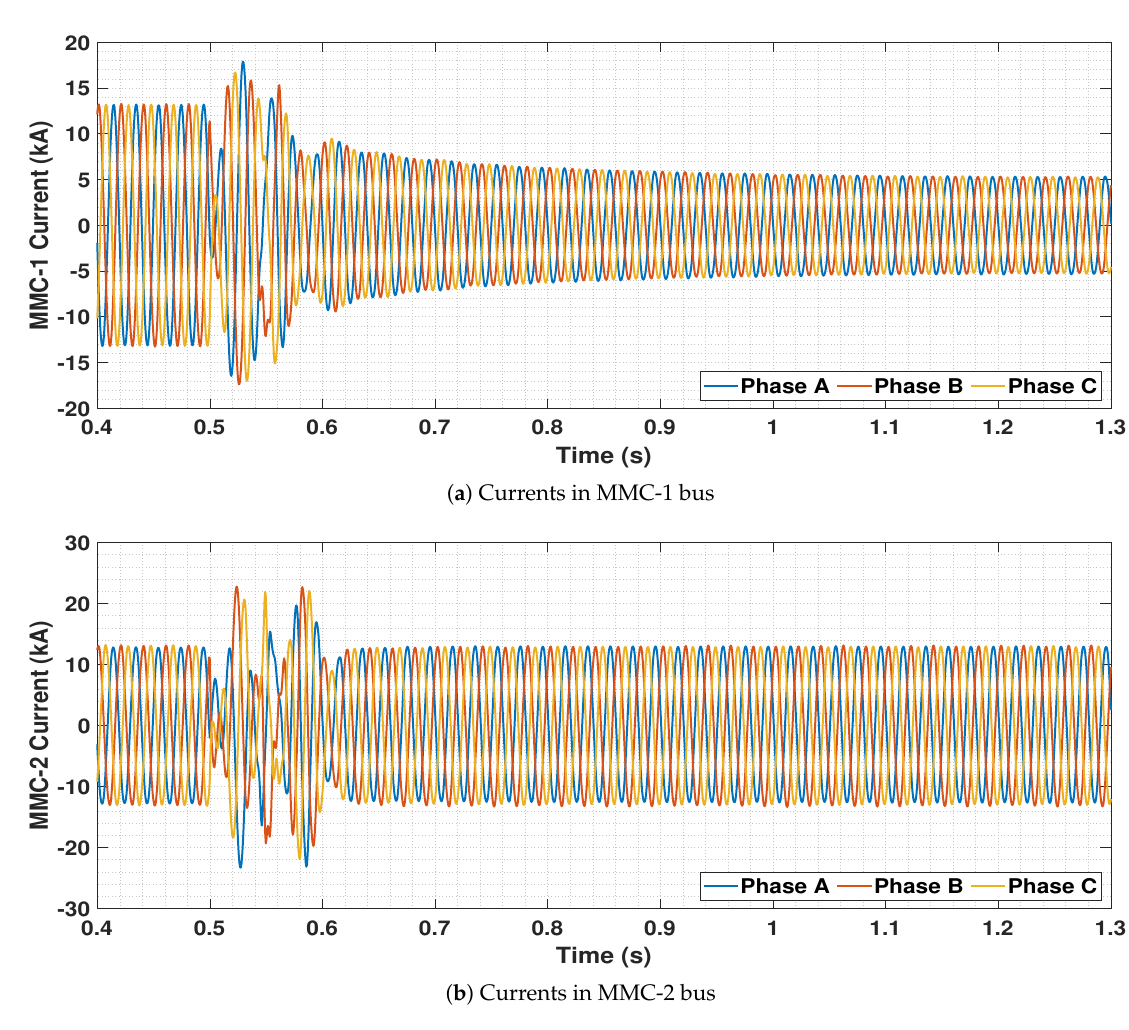
Figure 34. Currents in ( a ) MMC-1 bus and ( b ) MMC-2 bus upon three-phase line to ground fault in the middle of cable-1.